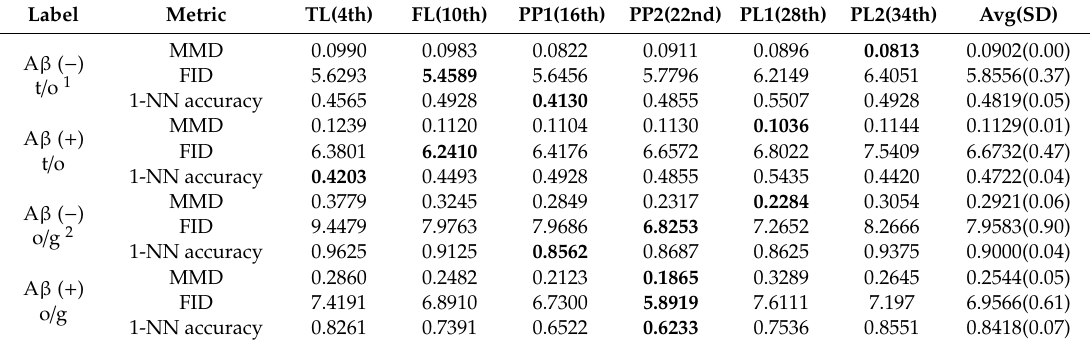
Table 2. Comparison of synthetic similarity using quantitative measurements of amyloid negative and positive images.